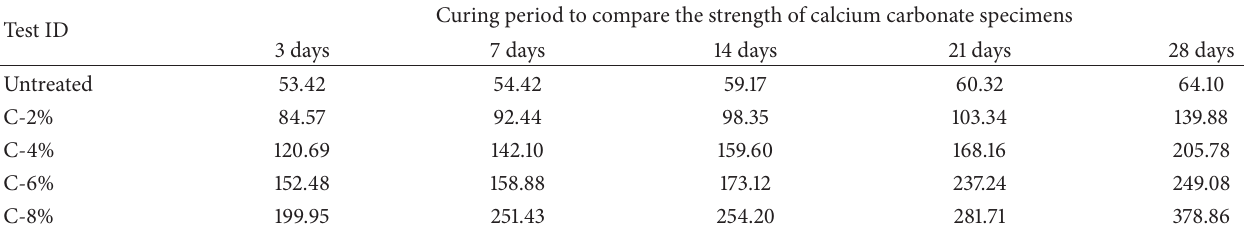
Table 3: Curing period to compare the strength of calcium carbonate specimens (unit: